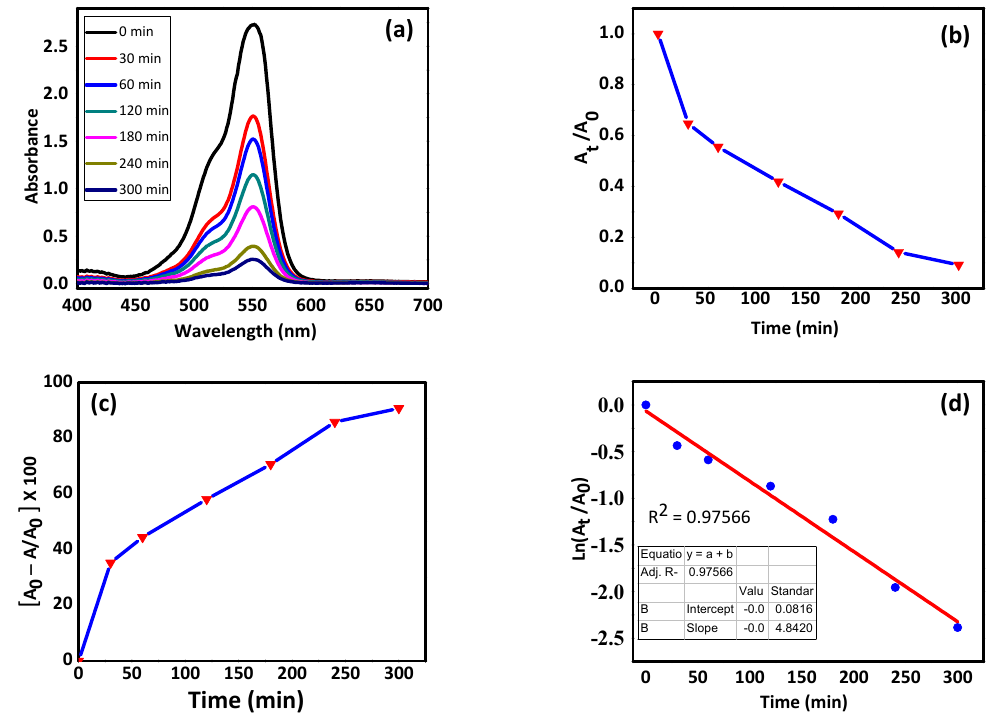
Figure 6. Degradation summary of RhB in the presence of 0.1 g CuO–SiO 2 particles under light. ( a ) Variation in UV-Visible spectra/absorbance at different intervals of time. ( b ) Ratio of absorbance (At/A 0 ) versus time. ( c ) Percentages of decomposition versus time. ( d ) Characteristic plot of pseudo- first-order kinetics of degradation.